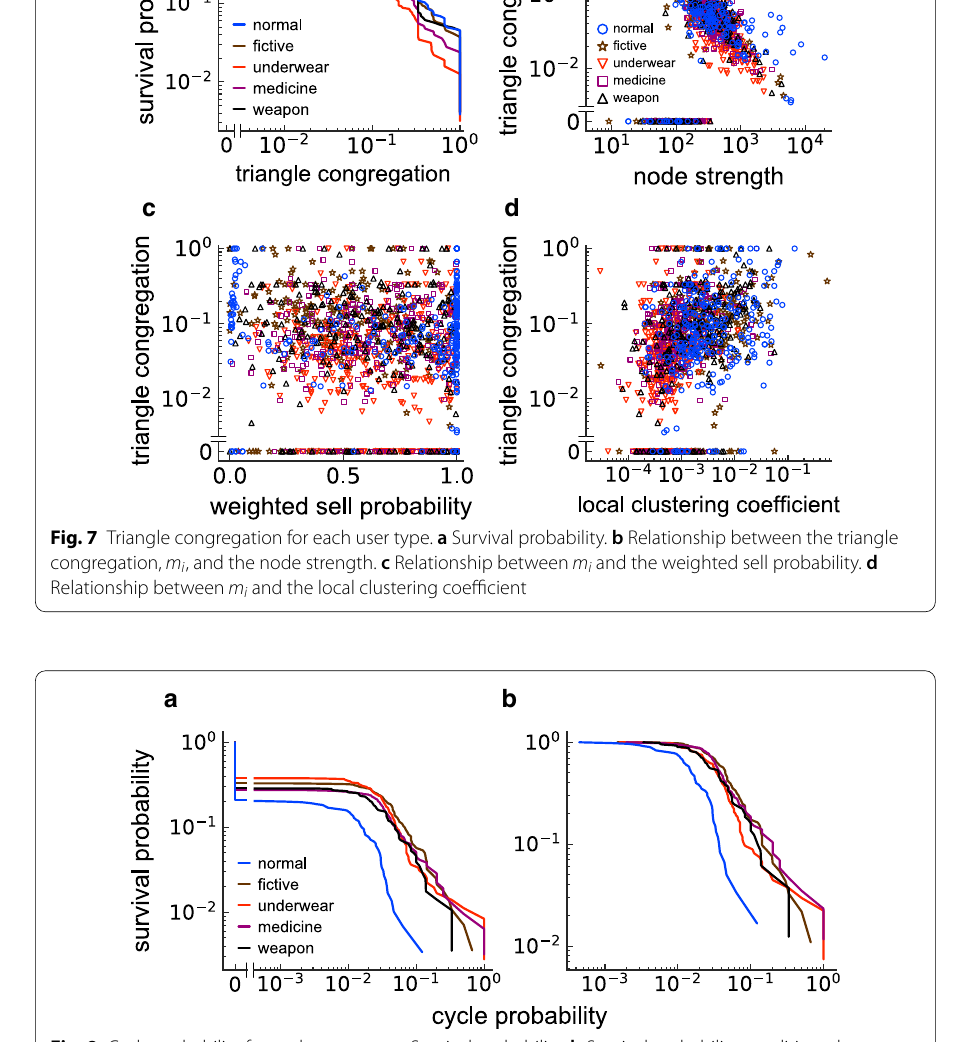
Fig. 8 Cycle probability for each user type. a Survival probability. b Survival probability conditioned on CYP i >